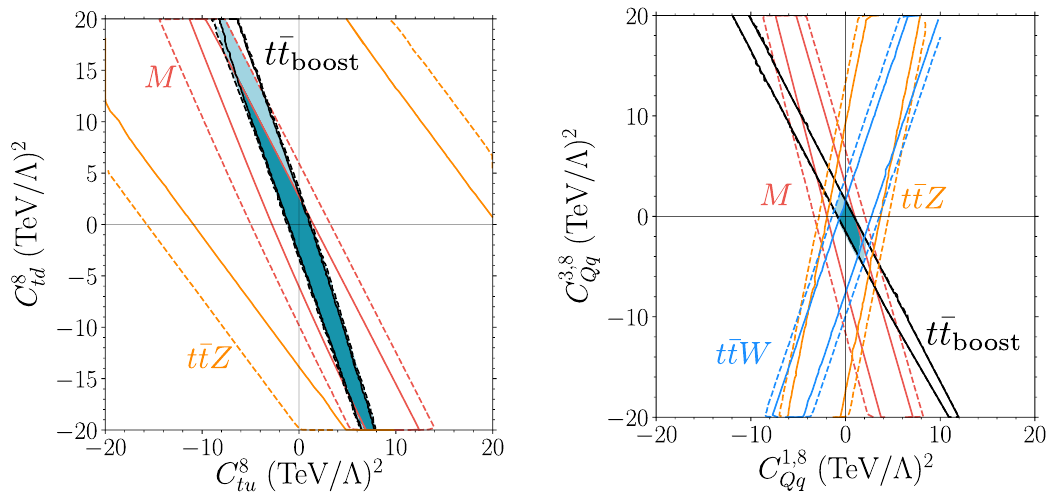
Figure 5 . Up-type versus down-type (left) and weak isospin (right) e(cid:11)ects of four-quark operators from LO two-parameter (cid:12)ts to order (cid:3) (cid:0) 2 . Solid and dashed lines mark the Gaussian equivalent of (cid:1) (cid:31) 2 = 1 ; 4 from (cid:12)ts to: set M of t (cid:22) t observables (red, see table 5), highest-energy bins of a t (cid:22) t distribution in the boosted regime, t (cid:22) tZ rates (orange), t (cid:22) tW rates (blue). The shaded areas show the combined